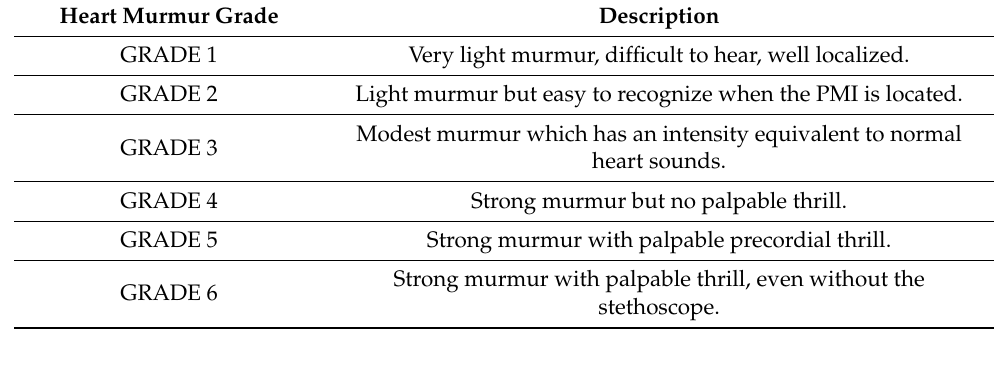
Table 1. Murmur grading scale in dogs.